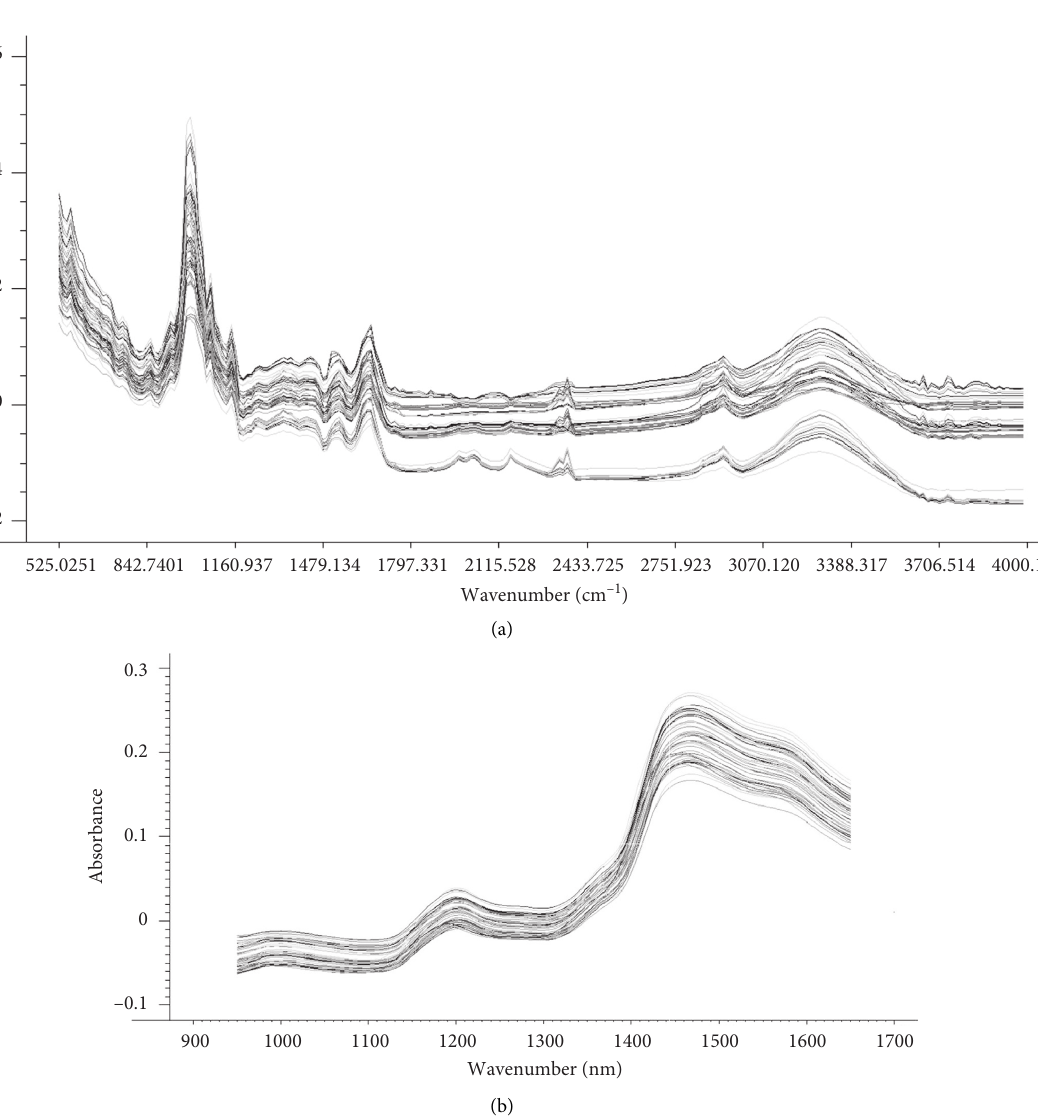
Figure 1: ATR-MIR and NIR spectra of wheat grain samples obtained in this study. (a) ATR-MIR spectra obtained in the range between 525 and 4000cm − 1 without pretreatment. (b) NIR spectra obtained in the range between 950 and 1650nm without Table 3: Develop and screening for the best calibration model for resistant starch in wheat grain samples using ATR-MIR and NIR spectra. Spectroscopy